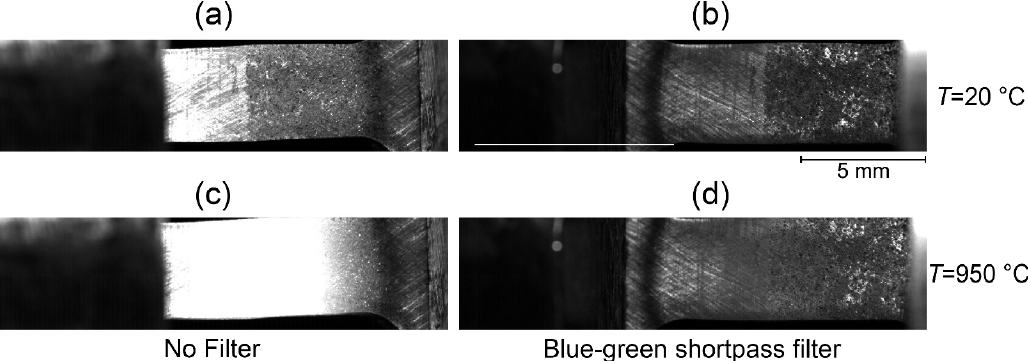
Figure 4. Optical images of a tensile sample at room temperature ( a , b ) and at 950 °C ( c , d ) imaged without a filter ( a , c ) and with a blue-green shortpass filter ( b , d ). The left side of the sample had a ground surface while the right side of the sample was patterned with a high-temperature spray paint. The bright hatched marks on the left side of the specimen are specular reflections from the ground surface.